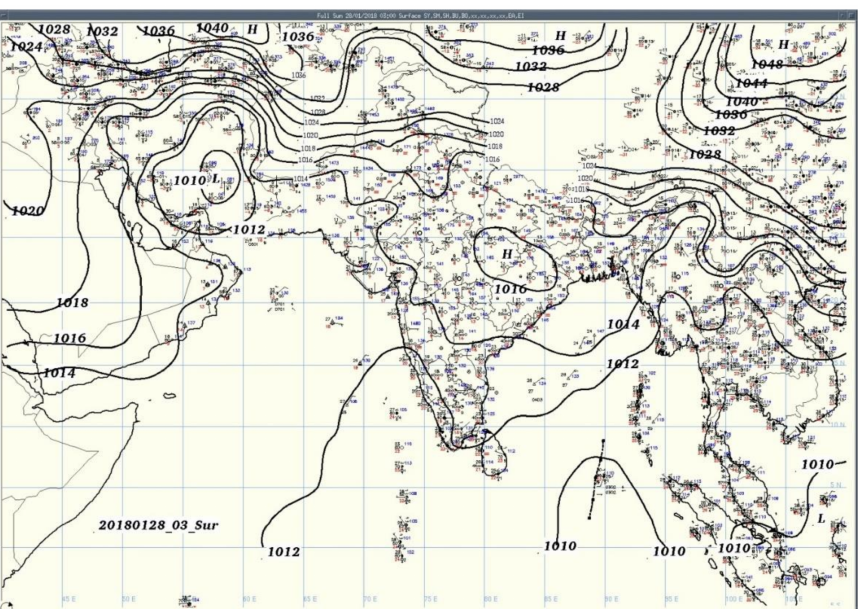
Figure 3. The India Meteorology Department (IMD) synoptic chart for 28 January 2018.